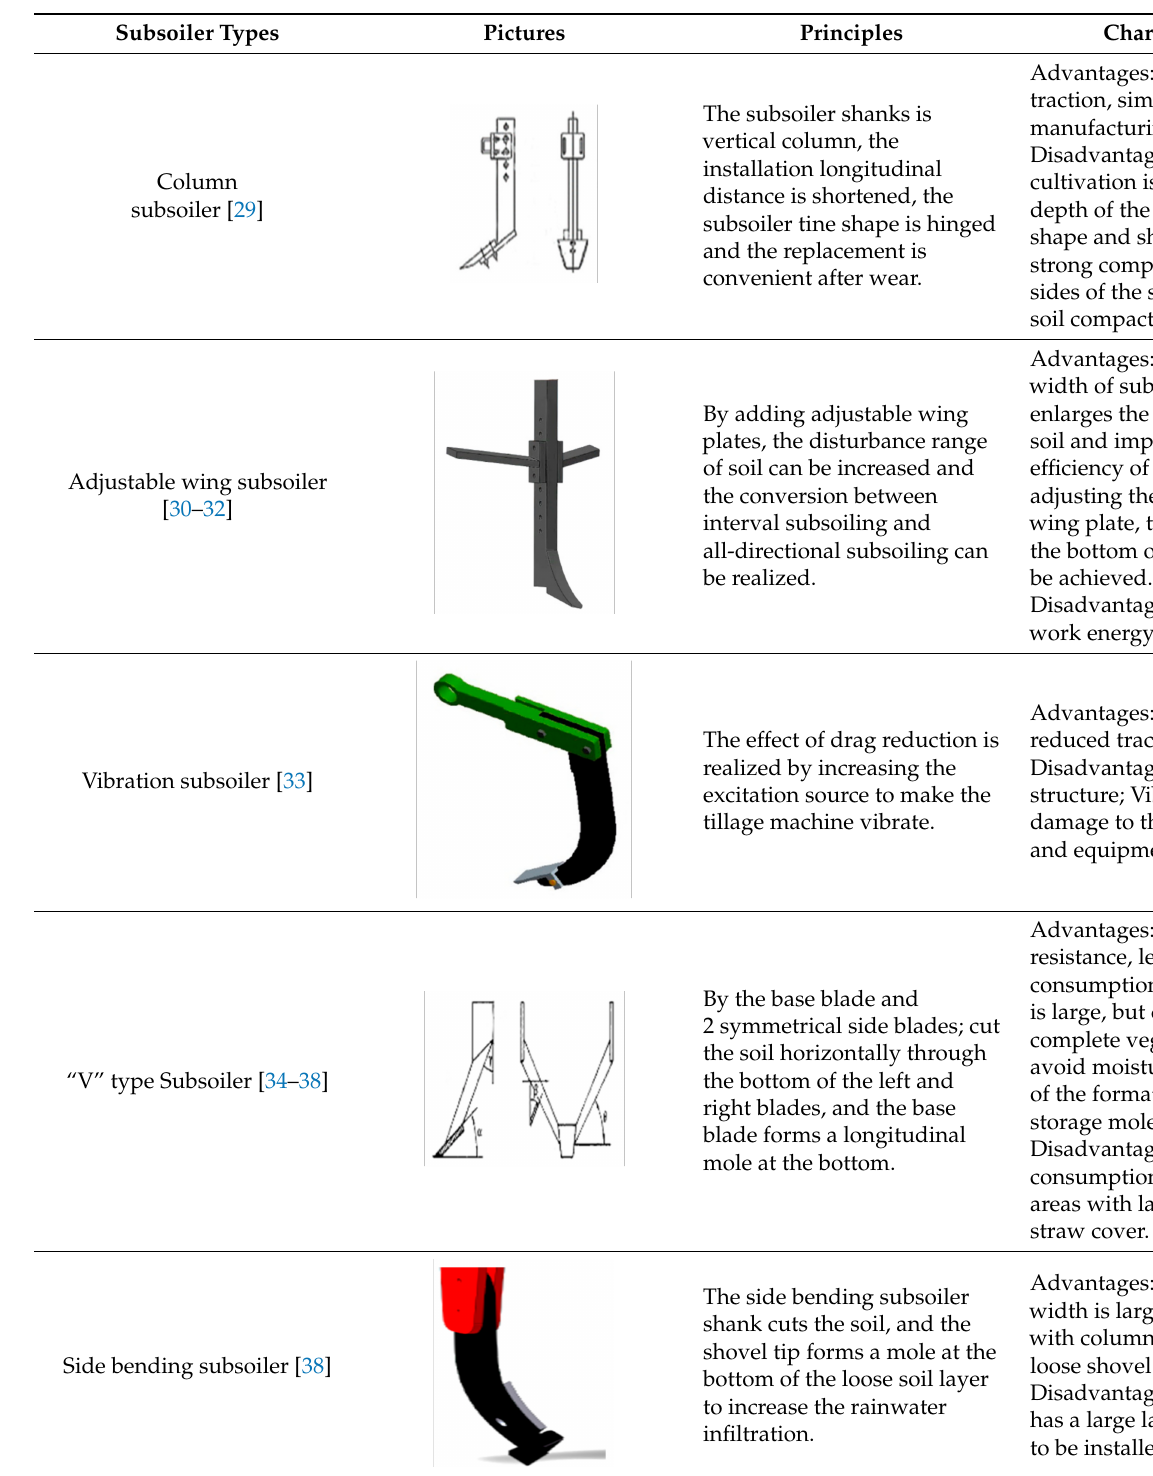
Table 3. The operating principles and characteristics of several typical subsoiling